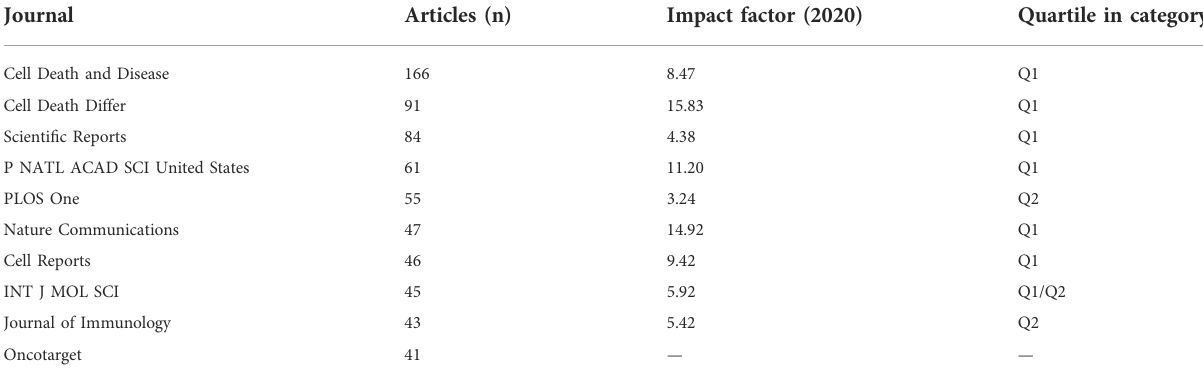
TABLE 3 The top 10 journal that have contributed to publications on necroptosis